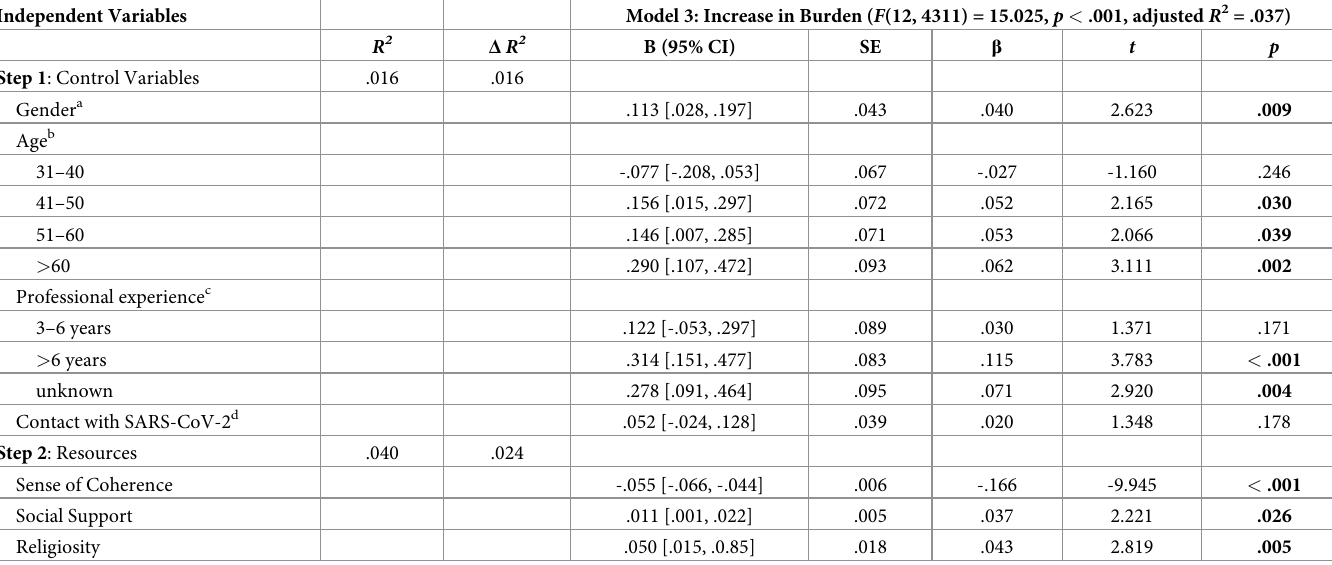
Table 5. Linear regression analysis for subjective increase in burden for the total